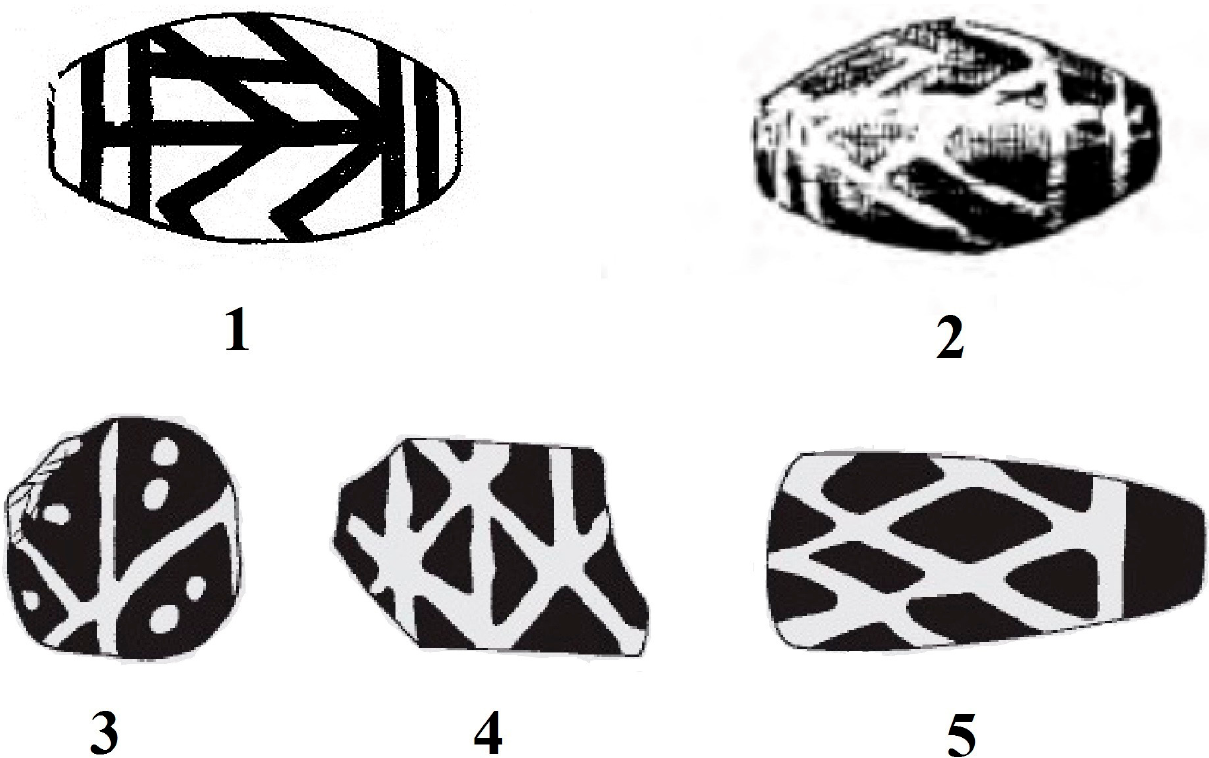
Figure 4. 1—Zharty-Gumbaz I burial ground, Pamir; 2—Daraut-Kurgan settlement, Alai; 3–5— Khotan area, Xinjiang (1—after B. A. Litvinsky (1972); 2—after A. N. Bernshtam (1952); 3 and 4—after Deyun Zhao (2014)).